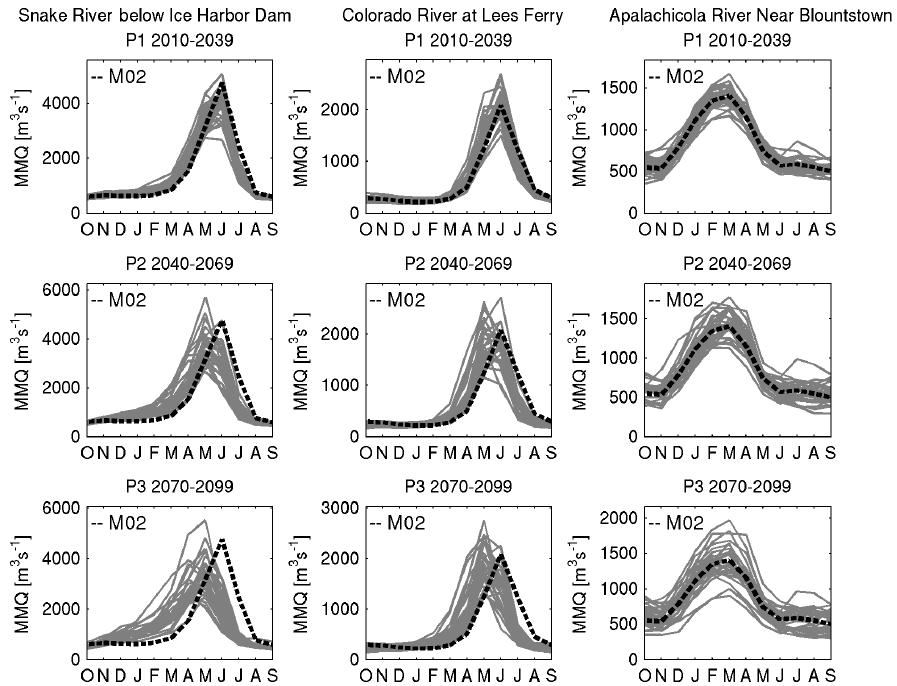
Figure 7. Monthly mean of CMIP5 projected streamflow at three locations indicated in Fig. 5. (left column- Snake River below Ice Harbor Dam, middle column – Colorado River at Lees Ferry, and right column – Apalachicola River near Blountstown). The river routing scheme is KWT. Monthly mean values are computed over three future periods (Top – P1 2010–2039, Middle – P2 2040–2069 and bottom – P3 2070– 2099). The dash line denotes streamflow estimated from runoff output from VIC forced by M02 historical data while gray lines indicate projected streamflow based on future runoff outputs from VIC forced by 28 CMIP5 RCP8.5